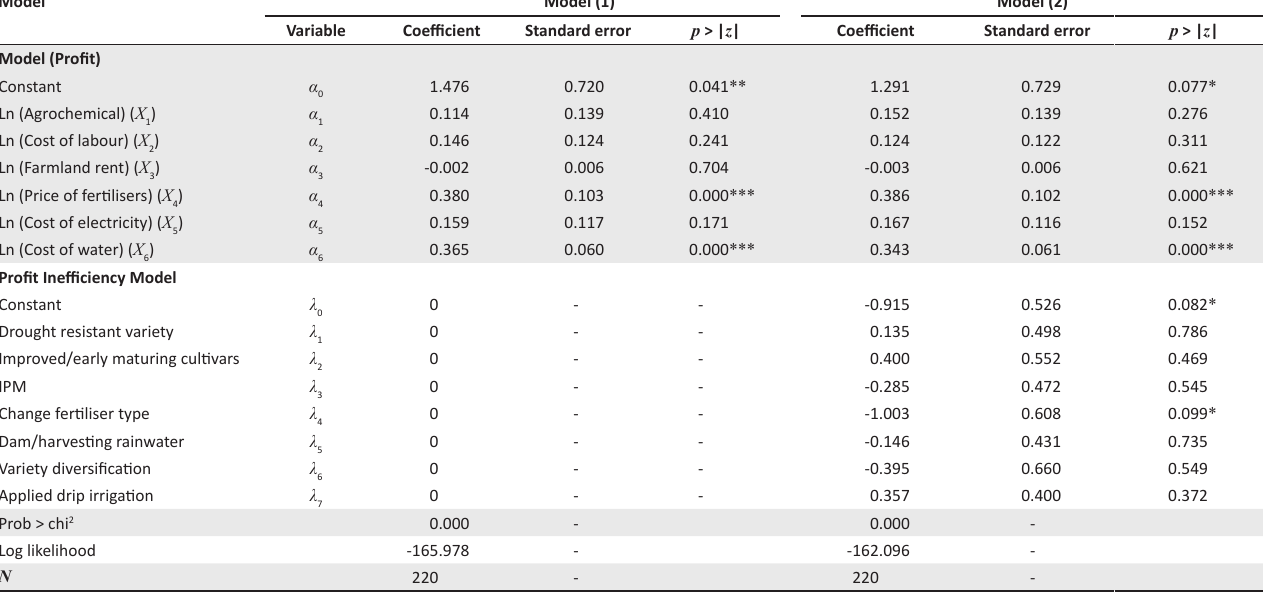
TABLE 4: The Maximum Likelihood Estimates (MLE) results of the stochastic frontier profit function and adaptation strategies for citrus farmers in the Limpopo province.